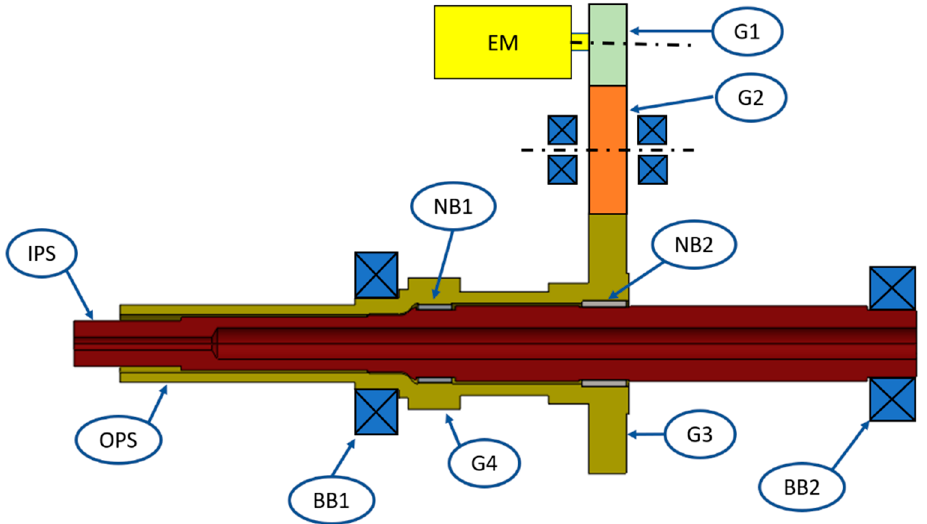
Figure 3. Setup for the static